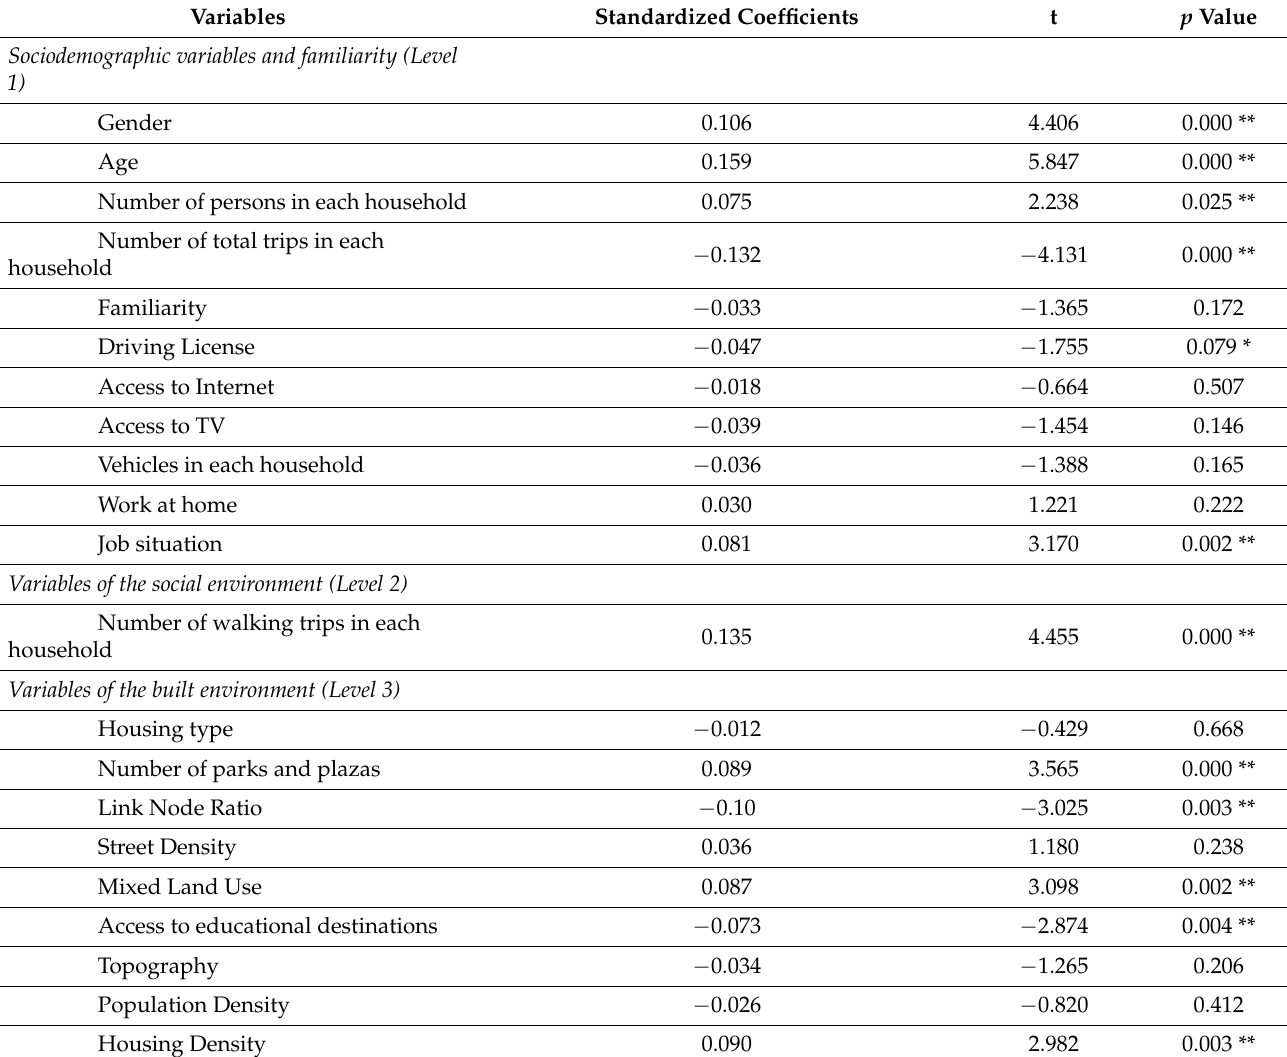
Table 3. The results of hierarchical multiple regression analysis for predicting walking behavior (overall walking) (N =